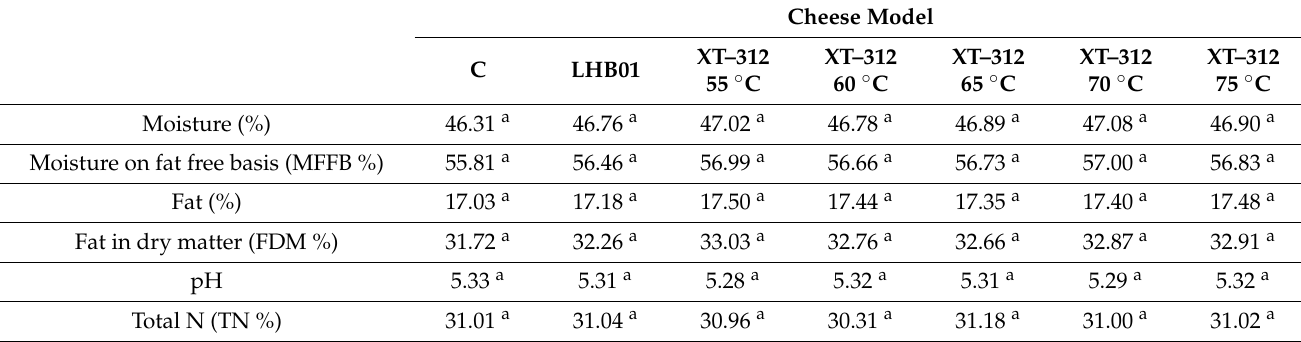
Table 2. Selected physicochemical traits of cheese models after 5 weeks of ripening.